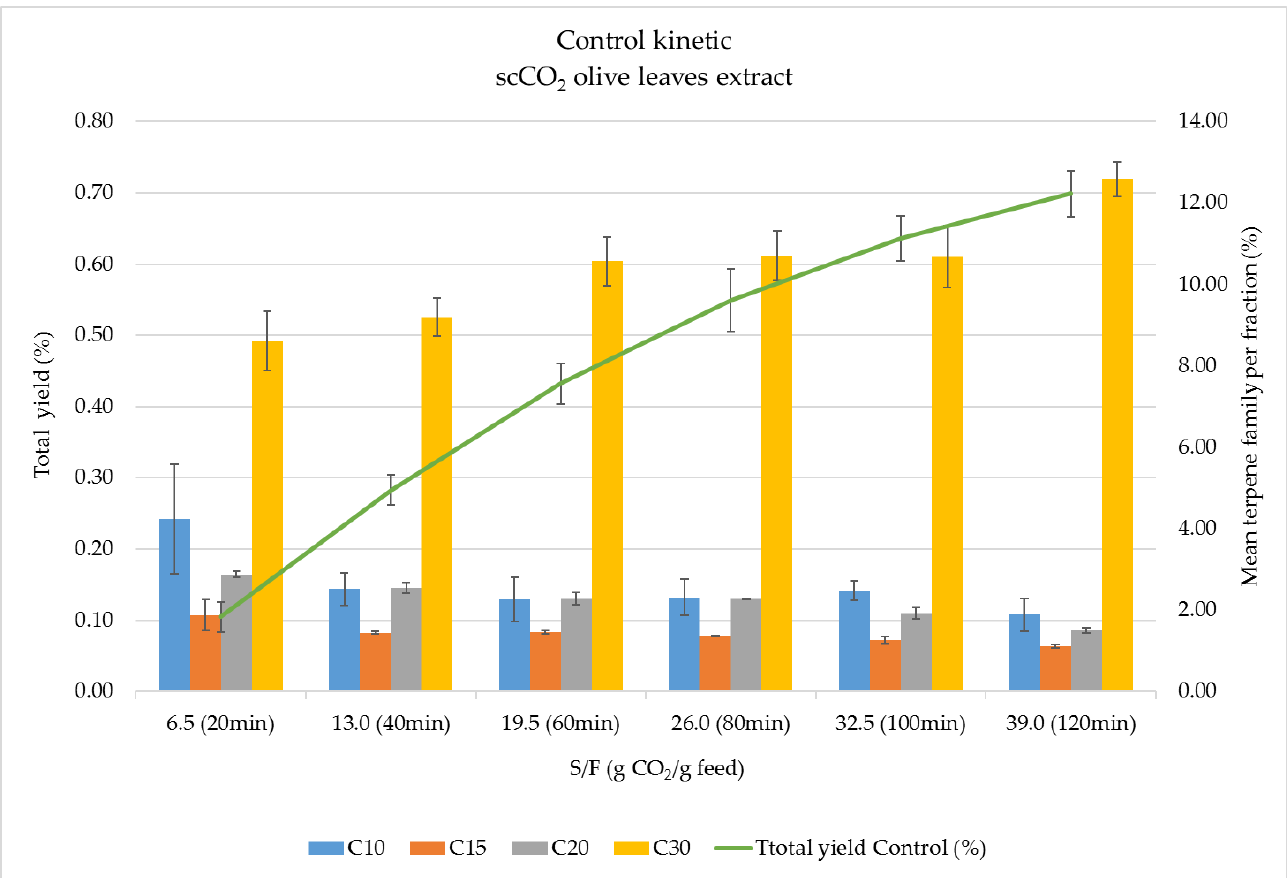
Figure 2. Total extraction yield (%) and terpene family abundance (%) in scCO 2 extracts from olive leaves obtained at different fractionation times for the control